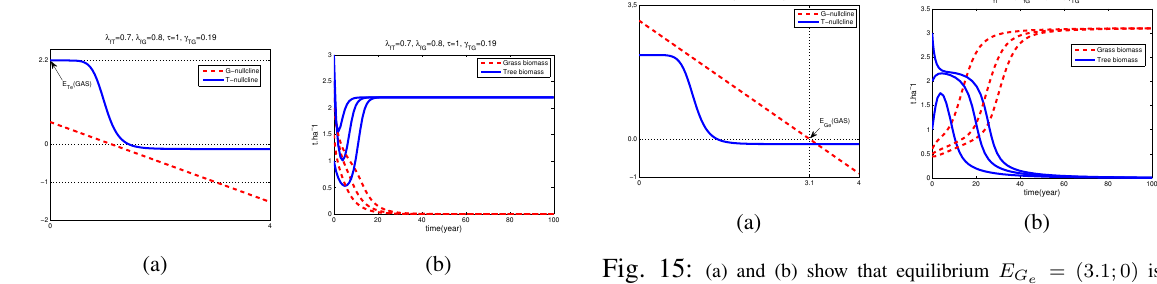
Fig. 13: Global stability of E